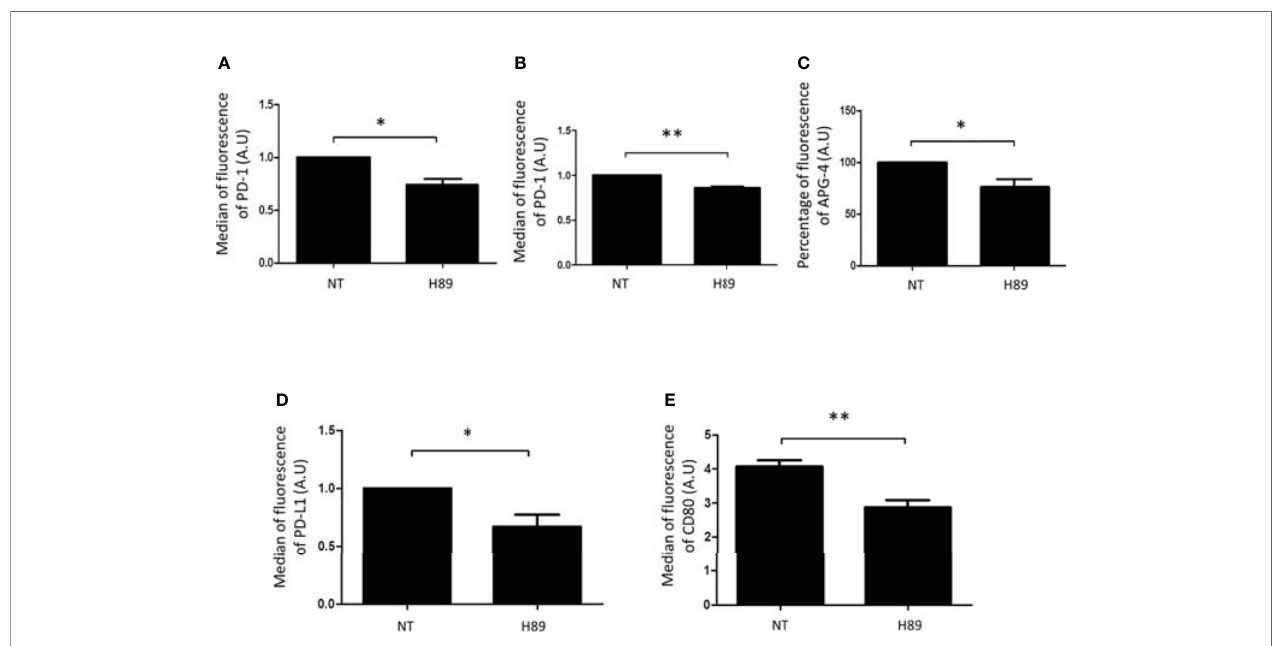
FIGURE 5 | H89 modulates immunosuppressive receptors expressed either by T cells or colon cancer cells. Flow cytometry analysis of PD-1 expression on CD4 + T cells isolated from the spleen of BALB/c mice (A) or MOLT-4 cells (B) cells treated by H89 for 24 h ( n = 3). Flow cytometry intracellular K + detection using APG-4 probe on splenic CD4 + T cells treated by H89 for 2 h ( n = 3) (C) . Flow cytometry analysis of PD-L1/CD80 expression on CT26 colon cancer cells treated by H89 for 24 h ( n = 3) (D, E) . Statistically signi fi cant differences were determined by using a t -test: * p ≤ 0.05; ** p ≤